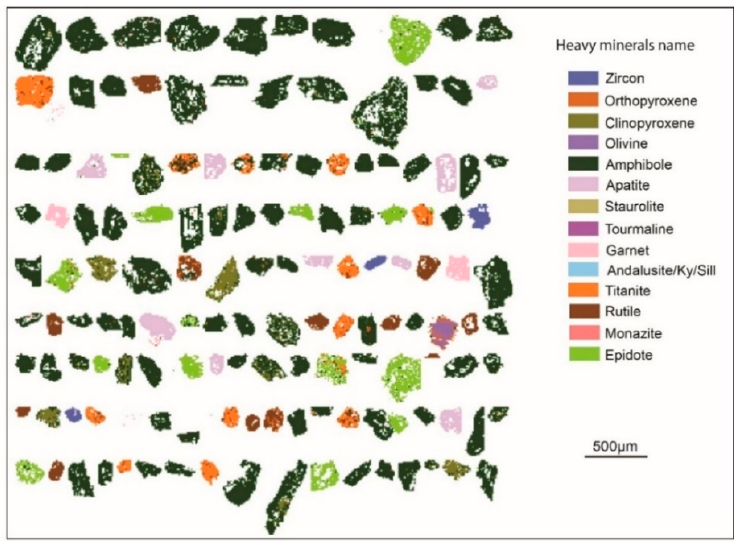
Figure 2. QEMSCAN image of heavy minerals in the modern Yellow River sample T0. Ky = Kyanite, Sill = Sillimanite.